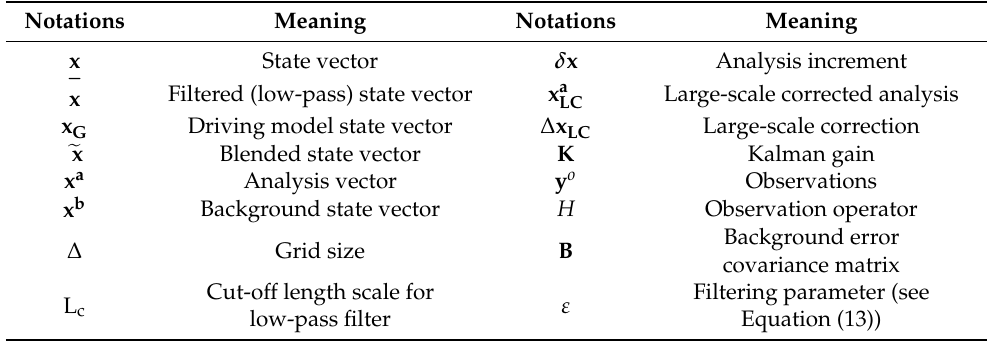
Table 1. List of variables with their notations.